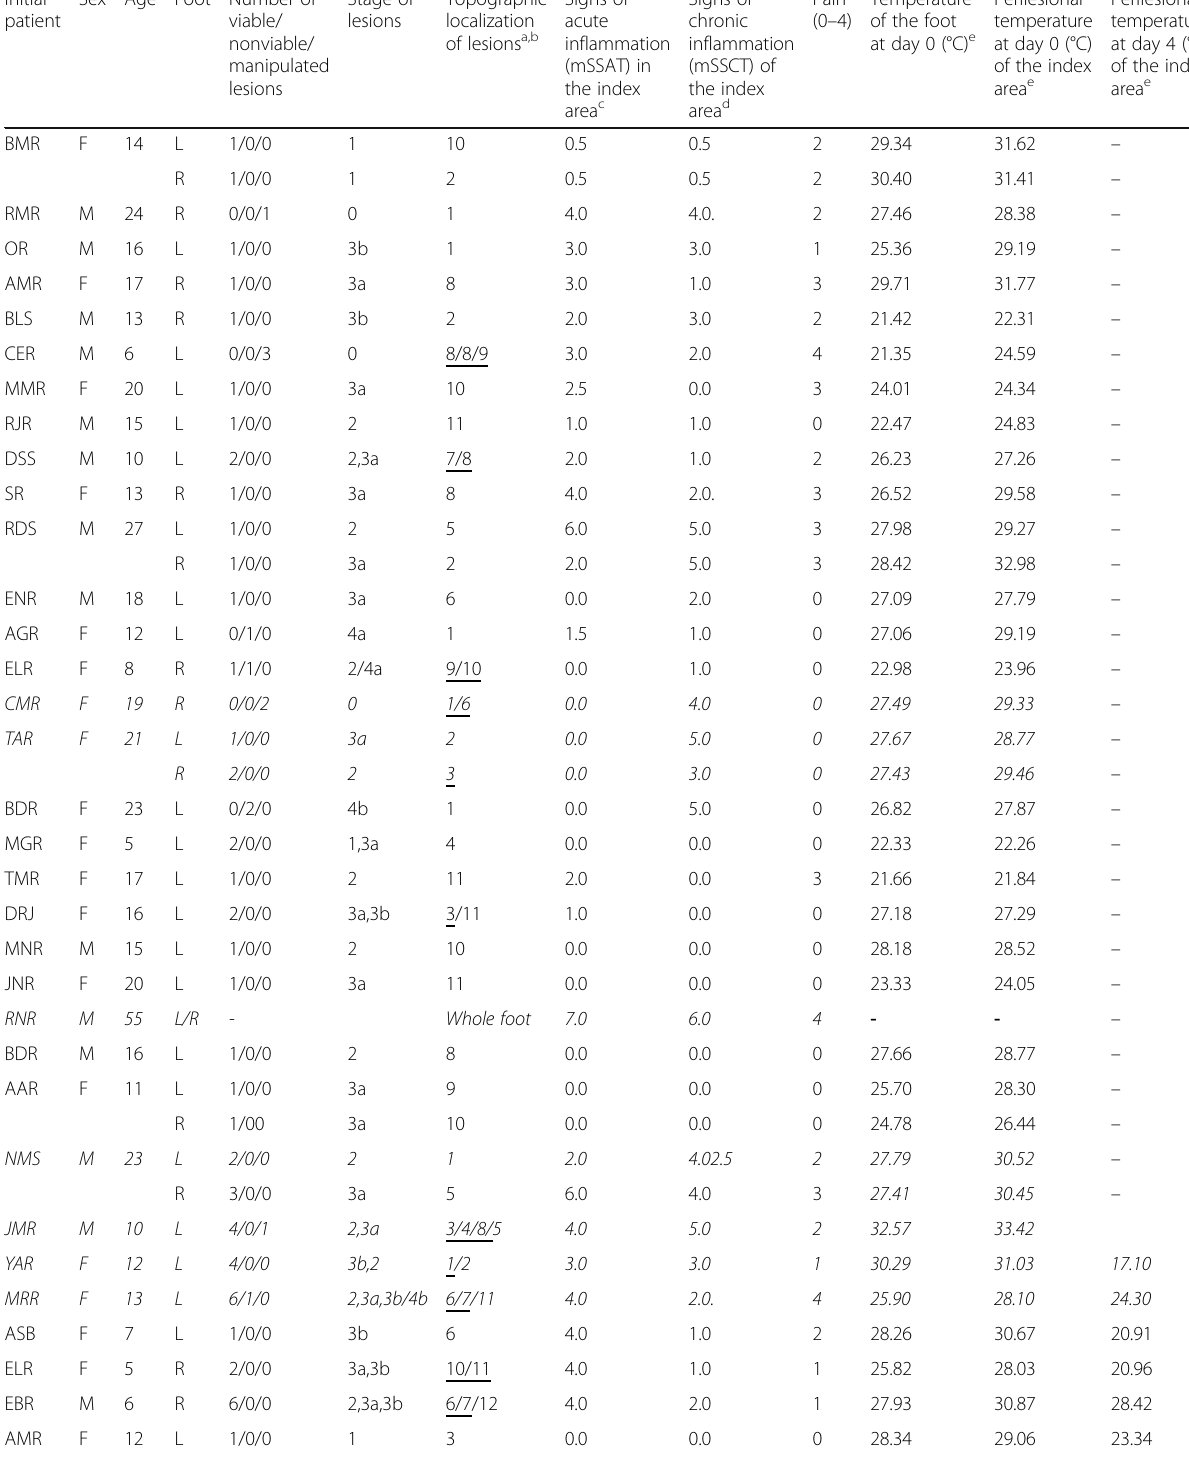
Table 3 Demographic, clinical and thermographic characterization of the patients ( N = 36); patients described in detail are marked in italics Initial Sex Age Foot Number of patient